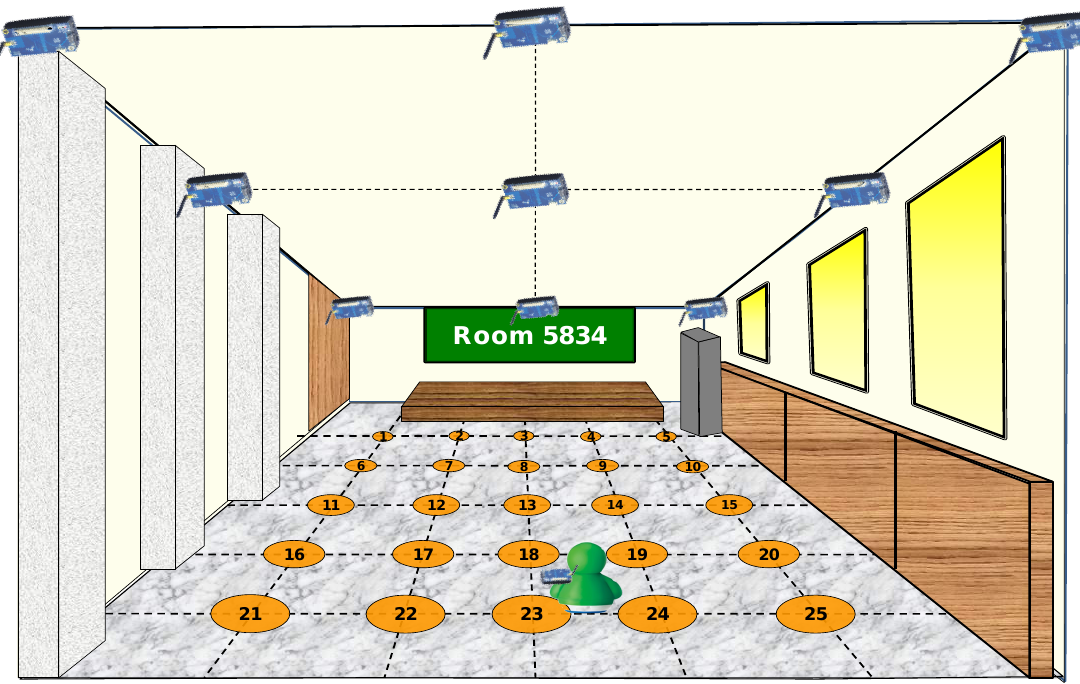
Figure 9. The arrangements of the equipments and the calibration of the grid